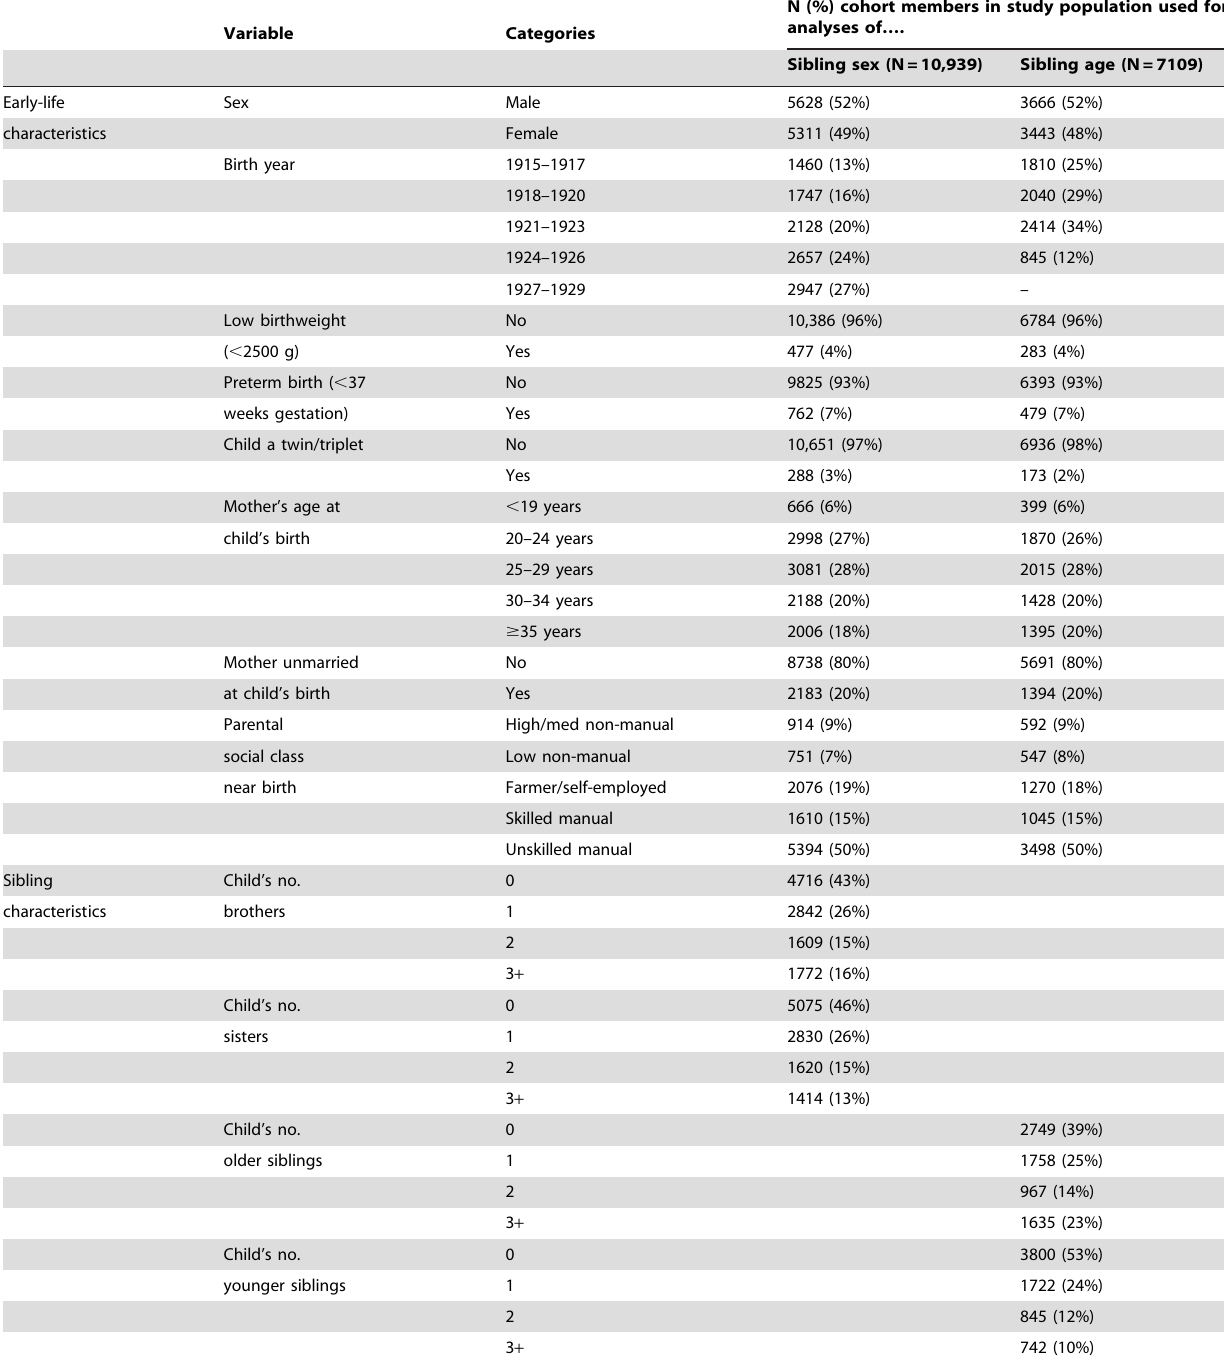
Table 1. Characteristics of Uppsala Multigenerational Birth Cohort